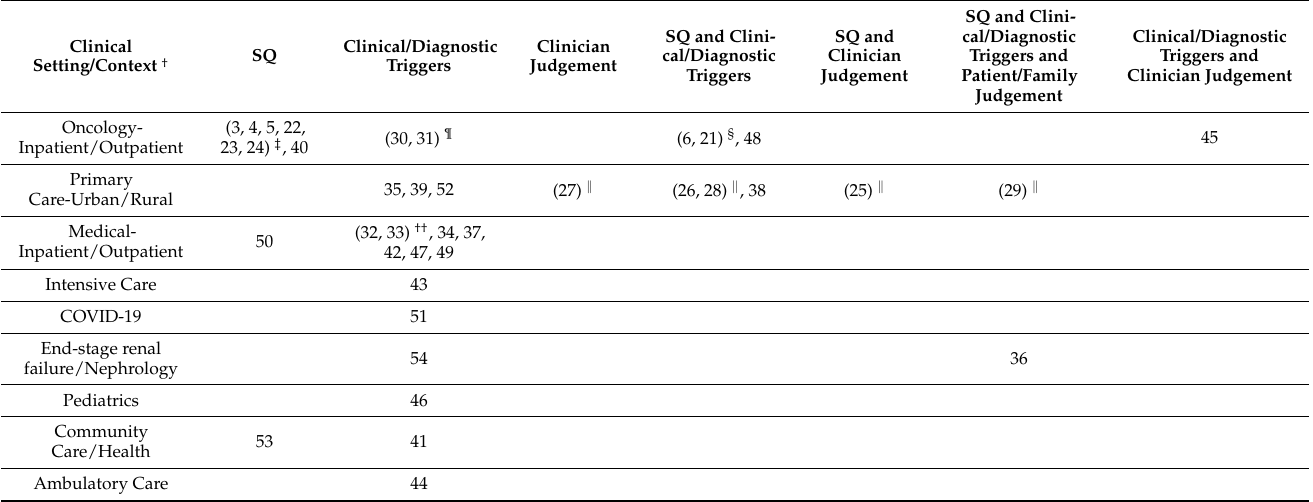
Table 2. Identification methods among population groups and clinical settings/contexts